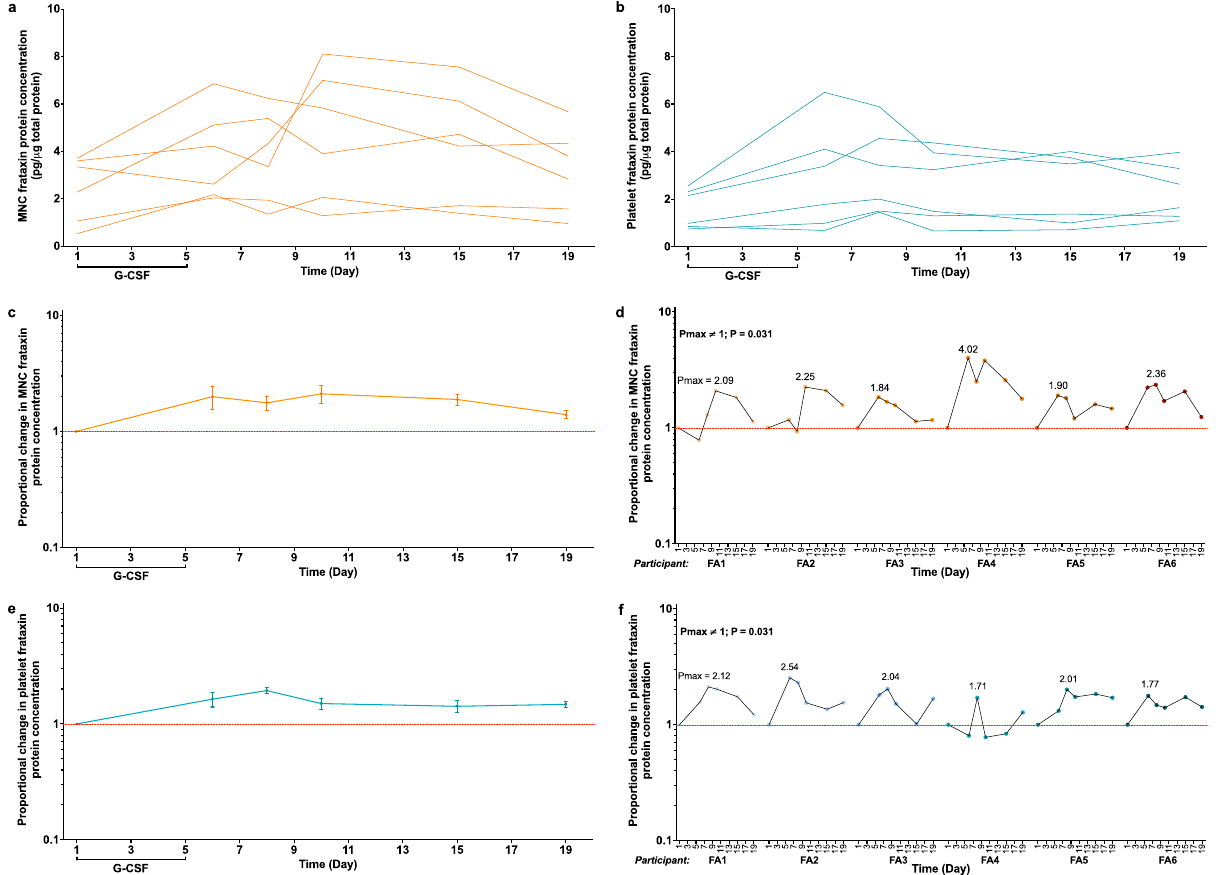
Fig. 3 G-CSF administration increases frataxin protein levels in both PB MNCs and platelets. The concentration of frataxin protein in ( a ) PB MNCs and ( b ) platelets over the 19-day study period from individual participants. The proportional changes in frataxin protein concentration in ( c ) PB MNCs and ( e ) platelets, relative to baseline (day 1) levels, over the 19-day study period (graph depicts mean ± standard error; n = 6 biologically independent samples); data from individual participants are shown in graphs ( d ; MNCs) and ( f ; platelets). The sign test (two-sided) was used to compare P max values to a theoretical median of 1.0. Source data are provided as a Source Data fi